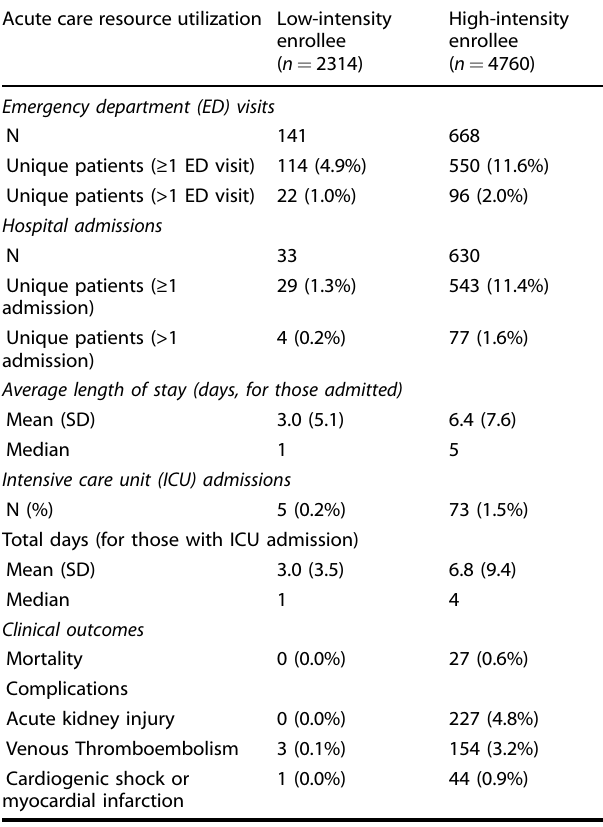
Table 6. Acute care resource utilization and clinical